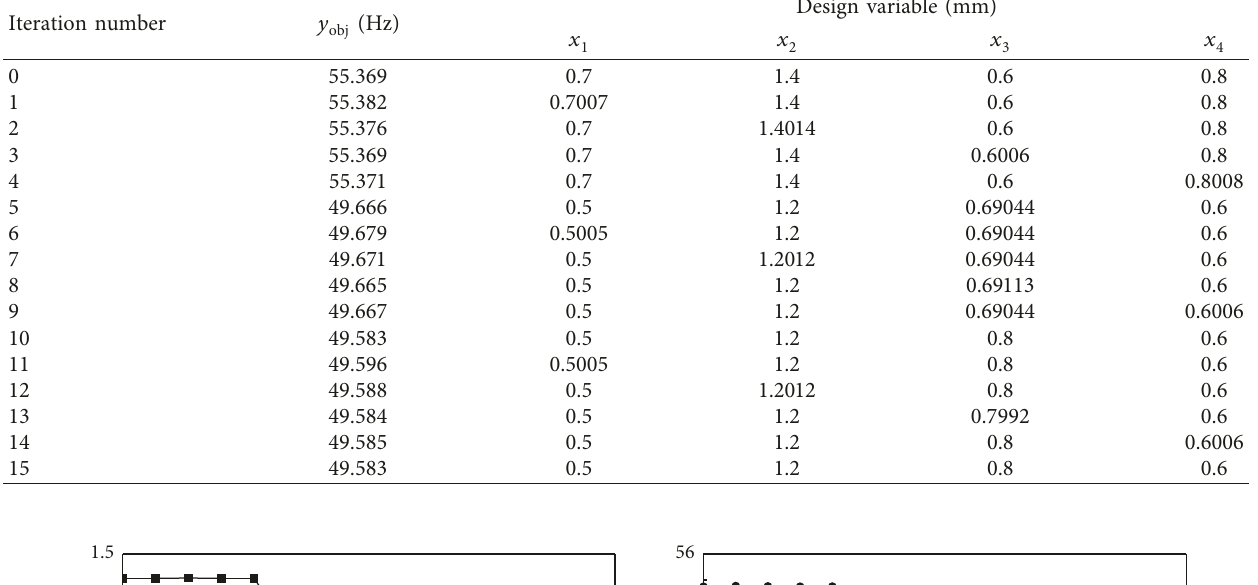
Table 5: Values of objective function and design variables with respect to iteration process.